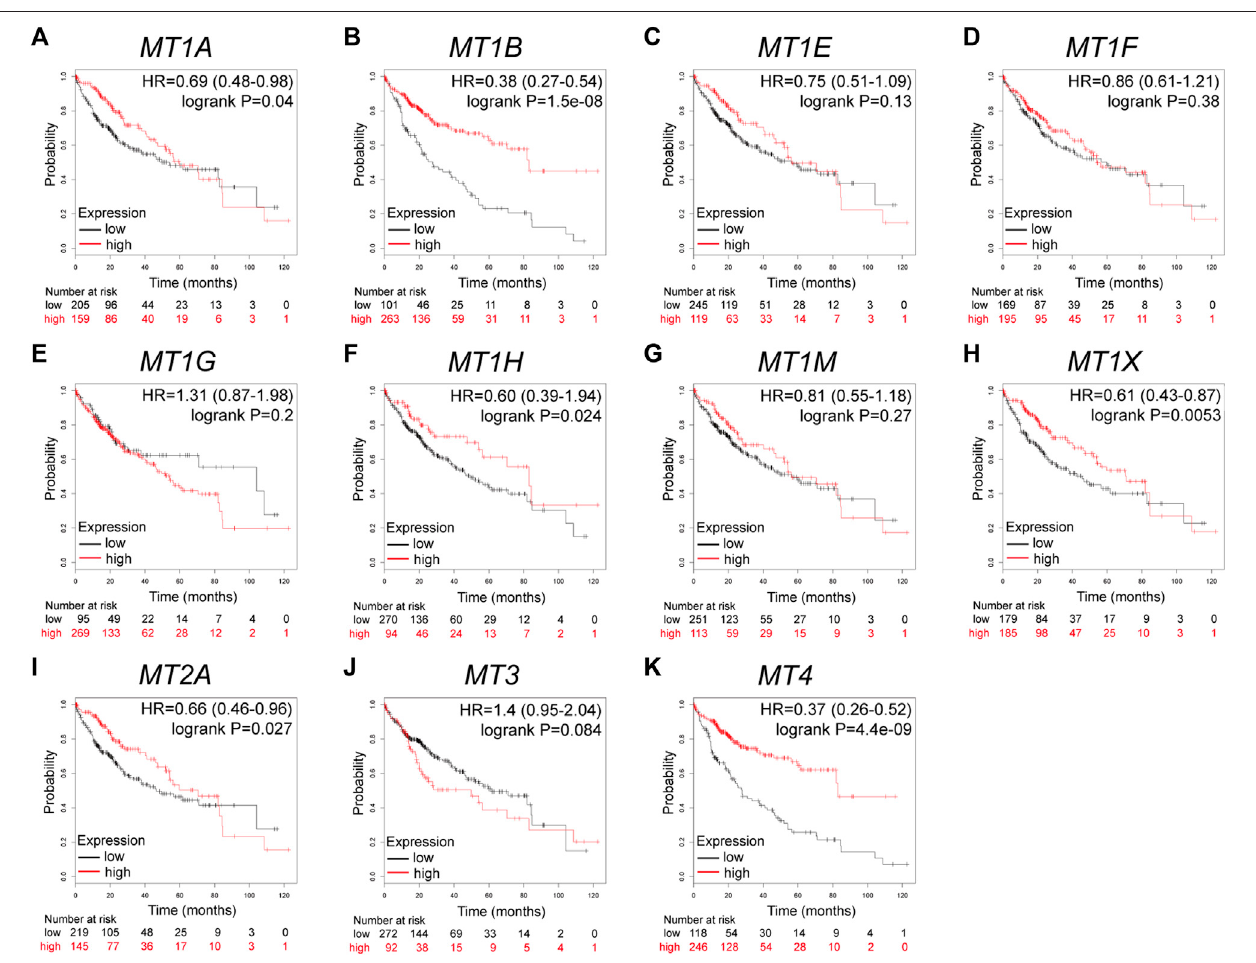
FIGURE 3 | Prognostic values of speci fi c MT isoforms in HCC: (A – K) OS in Kaplan – Meier plotter. The p -values were calculated by the log-rank test. OS, overall survival.